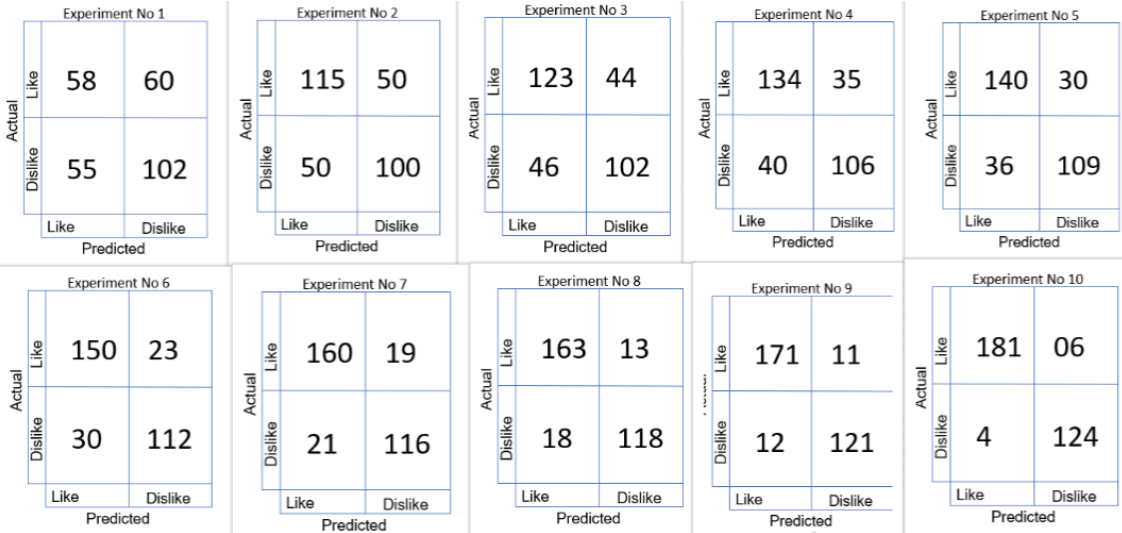
Figure 13. Comparison of confusion matrix for different experimental